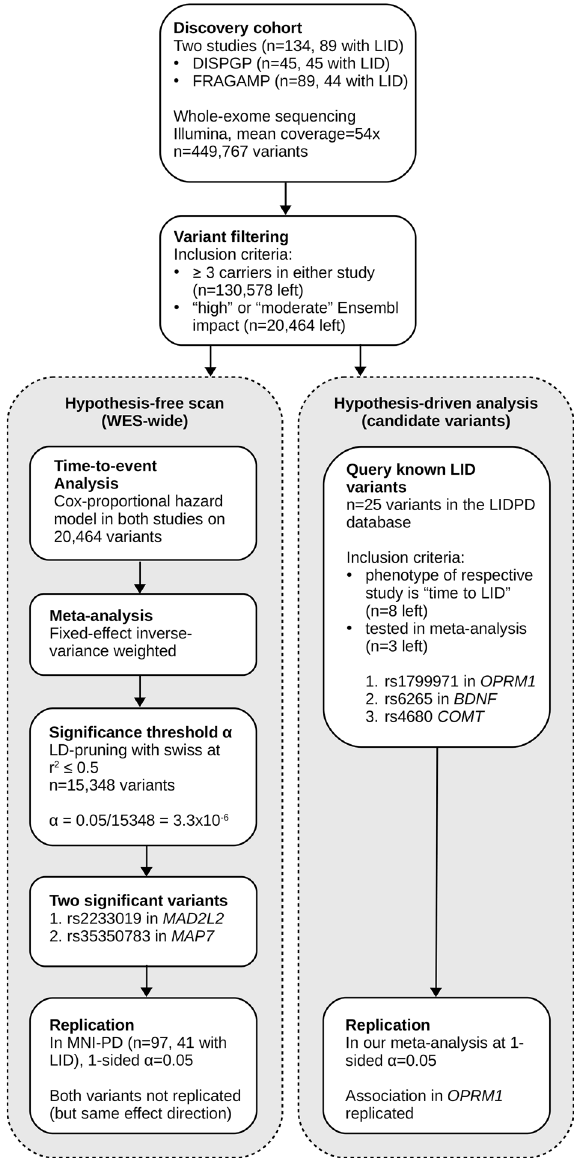
driven lookup of known candidate variants in our